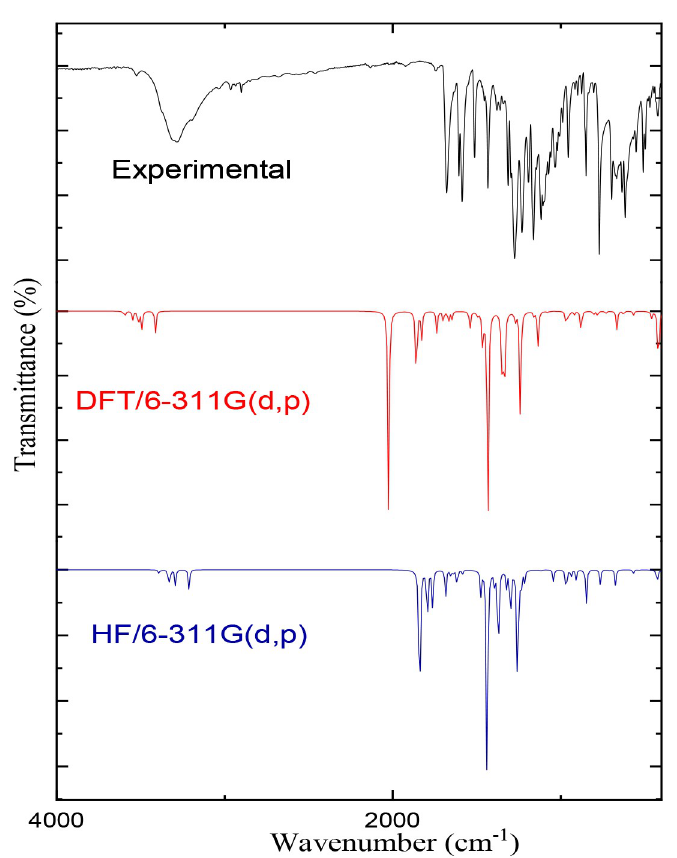
Fig 6. Comparative representations of FT-IR spectra for methyl 4-hydroxybenzoate.